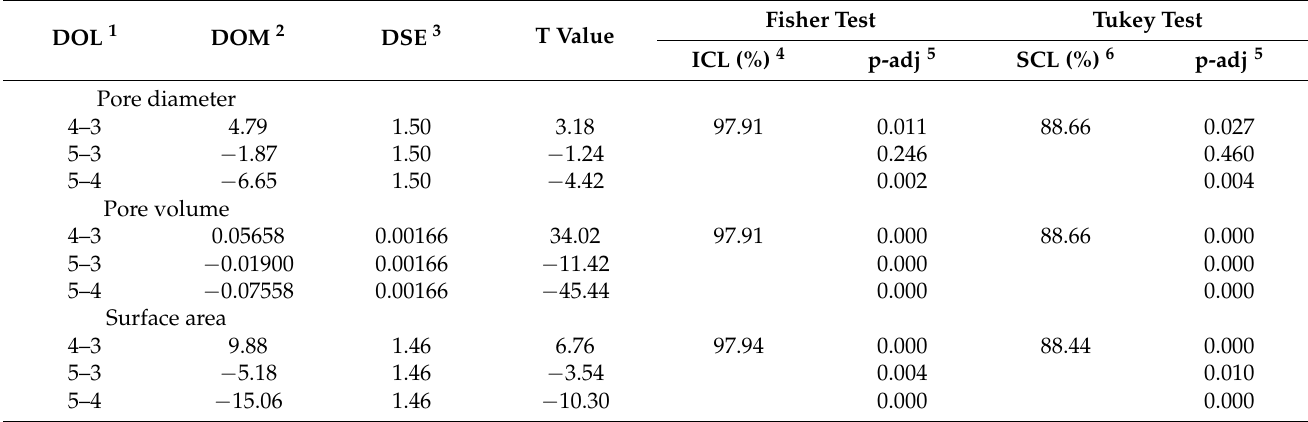
Table 3. Significance statistic for Fisher individual tests and Tukey simultaneous tests on surface properties of the Fe 3 O 4 @C nanocomposite